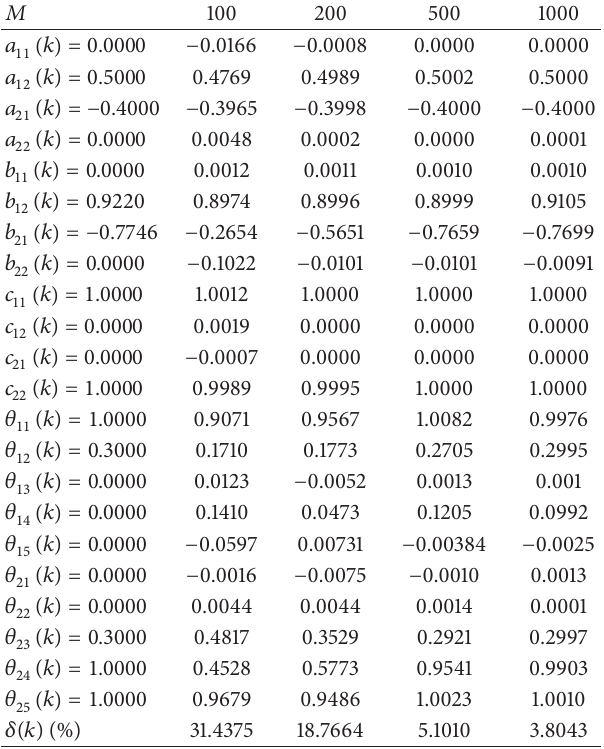
Table 2: The recursive parameter estimates and errors with 𝜎 𝑒2 =